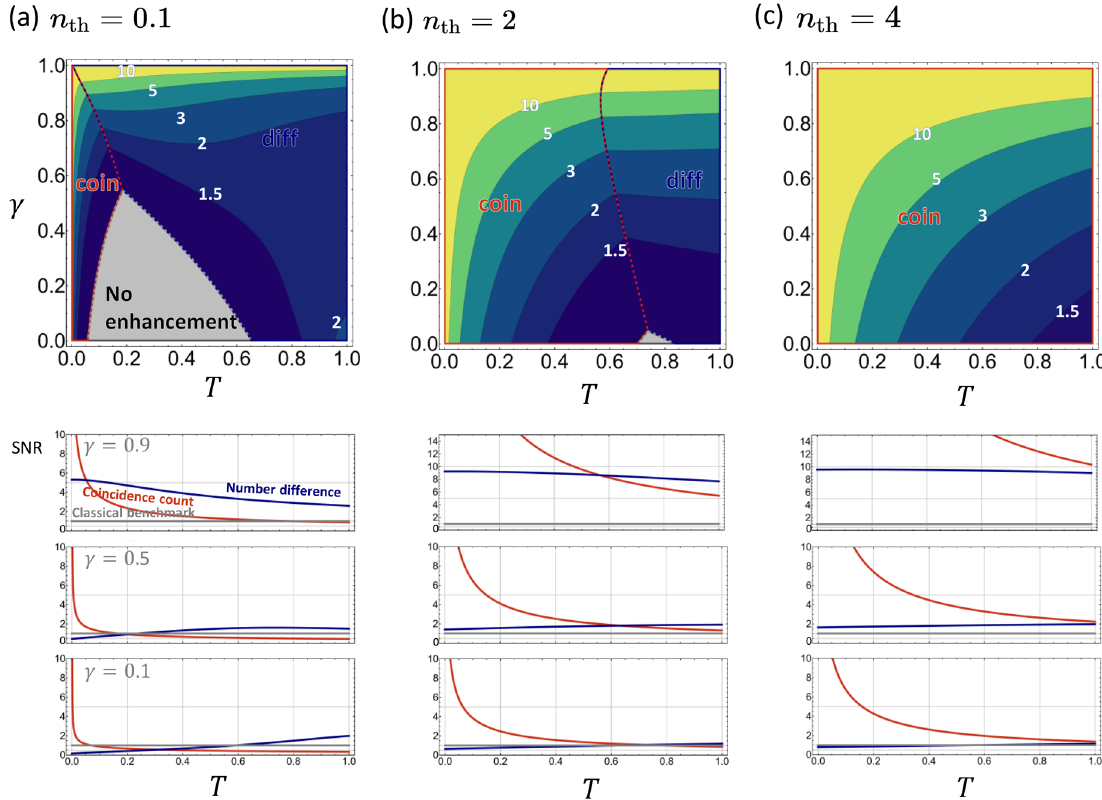
Figure 3. Top row: Quantum enhancement achieved by the TMSV state as quantified by R κ . The region in which the coincidence-counting scheme outperforms the number-difference and classical schemes is enclosed by the red box and is labeled ‘coin’ while the region dominated by the number-difference scheme is enclosed by the blue box and is labeled ‘diff’. The grey area indicates where no quantum advantage is observed by either 0.1, 0.5, and 0.9. Note that the coincidence- schemes. Bottom row: The ratio R κ as a function of T for γ = counting scheme becomes the best choice for all parameter values when n th is sufficiently